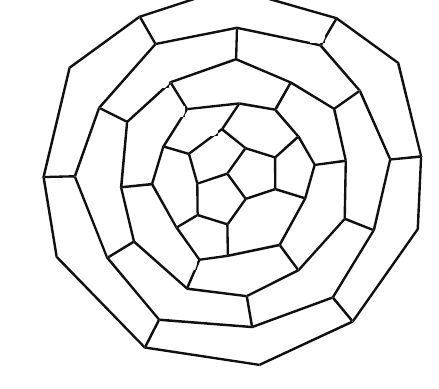
Figure 14. The subgraph B 1 .